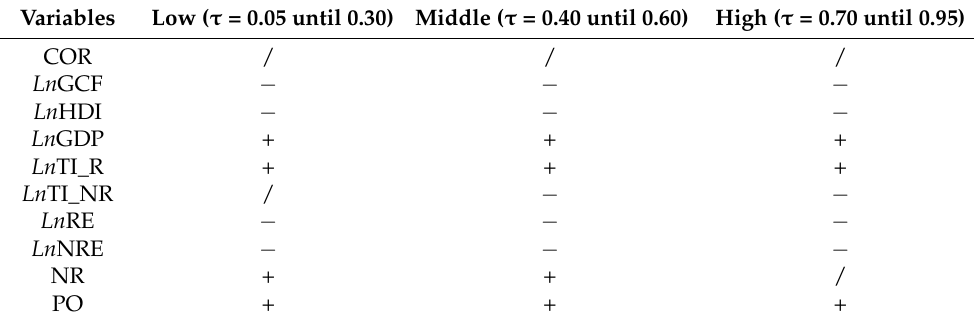
Table 8. Summary of quantile regression